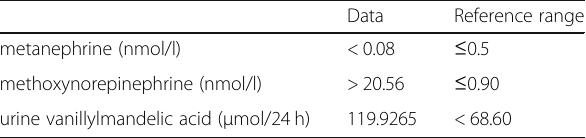
Table 1 Biochemical characteristics